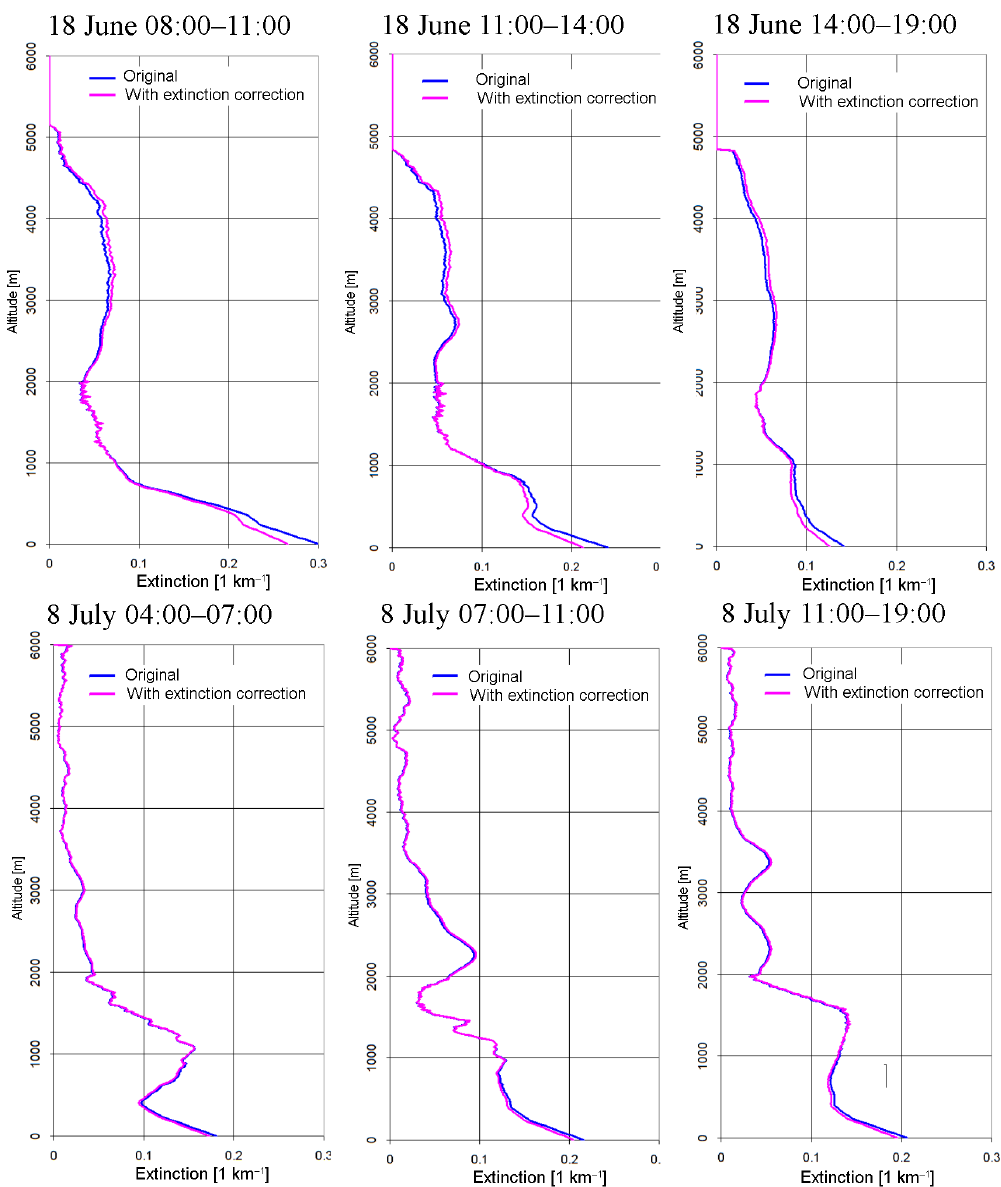
Figure A30. Comparison of profiles (linear extrapolation below 180m) without (blue) and with (magenta) extinction correction. Both profiles are scaled to the same total AOD (at 360nm) determined from the sun